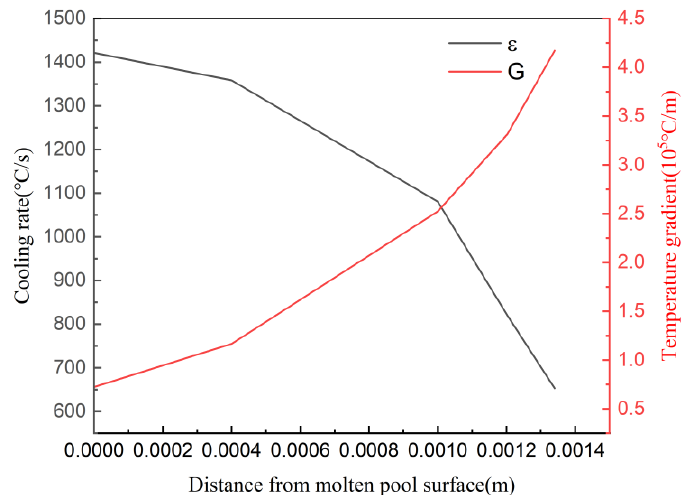
Figure 7. Solidification characteristics at different positions of the weld pool boundary. Through the temperature field simulation, the characteristic parameters of the edge solidification of the NiCoCrAlY molten pool formed on the surface of the 617 nickel-based alloy were simulated. It was found that as the distance from the molten pool increases, the cooling rate decreases, the temperature gradient increases, and the solidification rate decreases. At the same time, analysis of the temperature gradient at the back of the molten pool found that the surface vector direction is consistent with the electron beam movement direction ( x -axis), and the vector direction at the bottom of the molten pool is perpendicular to the surface ( z -axis). According to the theory of dendrite growth, the dendrites near the metallurgical bonding zone grow along the z -axis direction, and the dendrites on the surface of the alloy layer grow along the z -axis direction. According to solidification theory, the characteristic parameters of solidification affect the structure and size distribution of the electron beam cladding layer. As shown in Figure 8, the solidification organization and size were related to the characteristic parameters, along the depth of the molten pool; as the temperature gradient G increased and the solidification velocity v decreased, the shape control factor describing the solidification structure gradually increased. At the same time, as the cooling rate in the depth direction decreased, the size of the structure changed from fine to thick. Based on this, it can be predicted that the molten pool surface k is small and ε is large, causing the top of the molten pool to show mainly fine isometric crystals. The bottom of the molten pool has a large k and a small ε , resulting in a relatively coarse dendrite at the bottom; in the middle of the molten pool, k changes from small to large and ε changes from large to small, so the middle part is mainly manifested as transitional short dendrites.